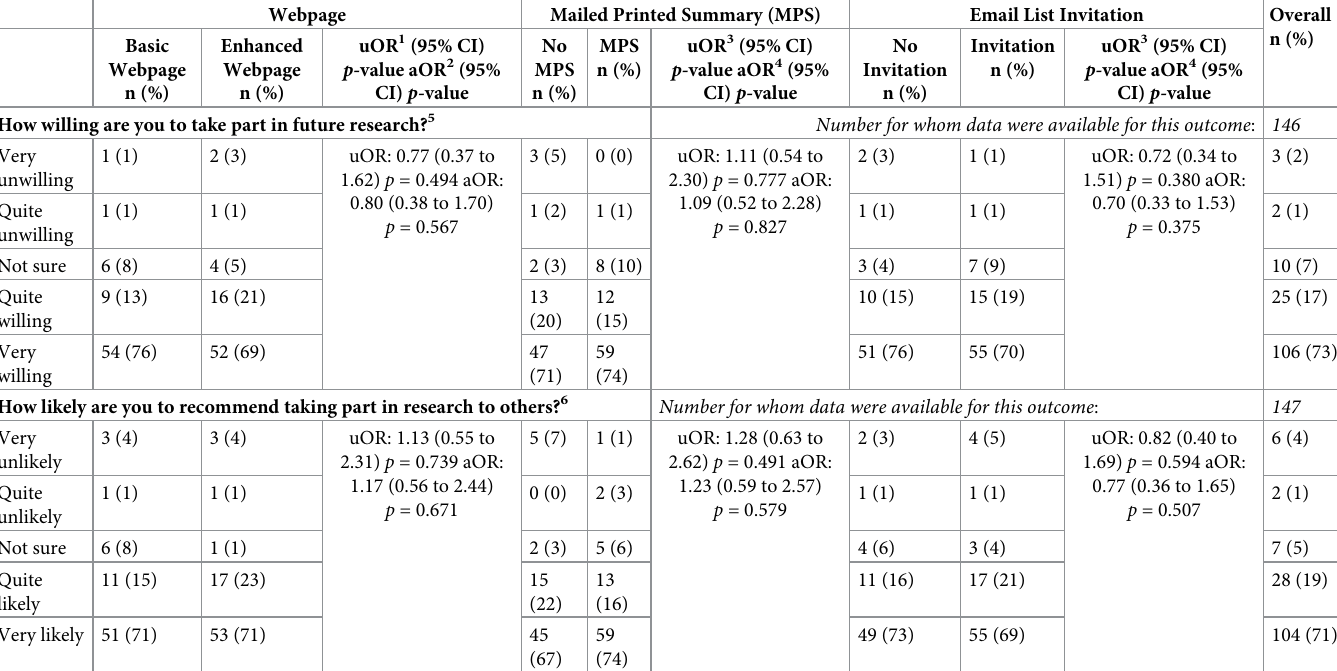
Table 7. Reported outcomes relating to take part in or recommend taking part in